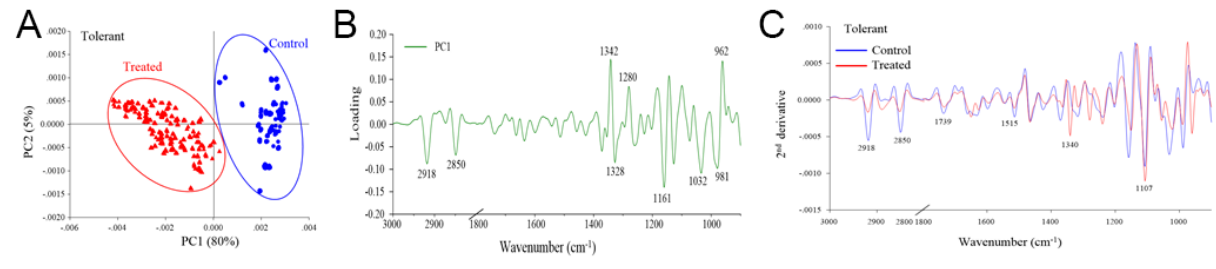
Figure 4 ( A ) Representative PCA score plot of tolerant plants under drought stress conditions and control conditions. ( B ) Loading plot of PC1 from the PCA. ( C ) Second-derivative-transformed spectra. e obtained spectra were analyzed in the regions of 3,000–2,800 cm − 1 and 1,800–900 cm − 1 .